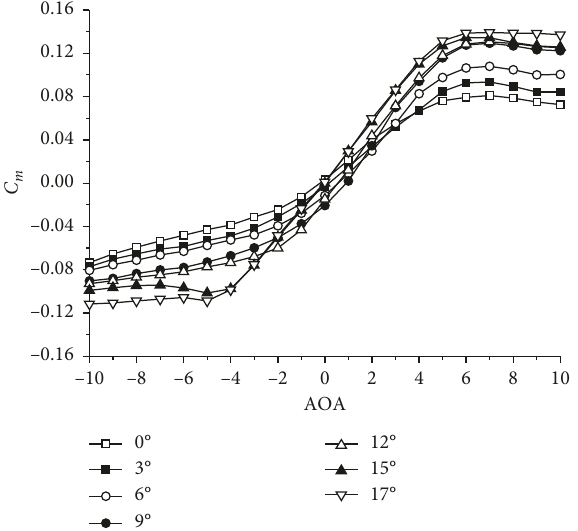
Figure 17: C m vs. AOA for various box slope